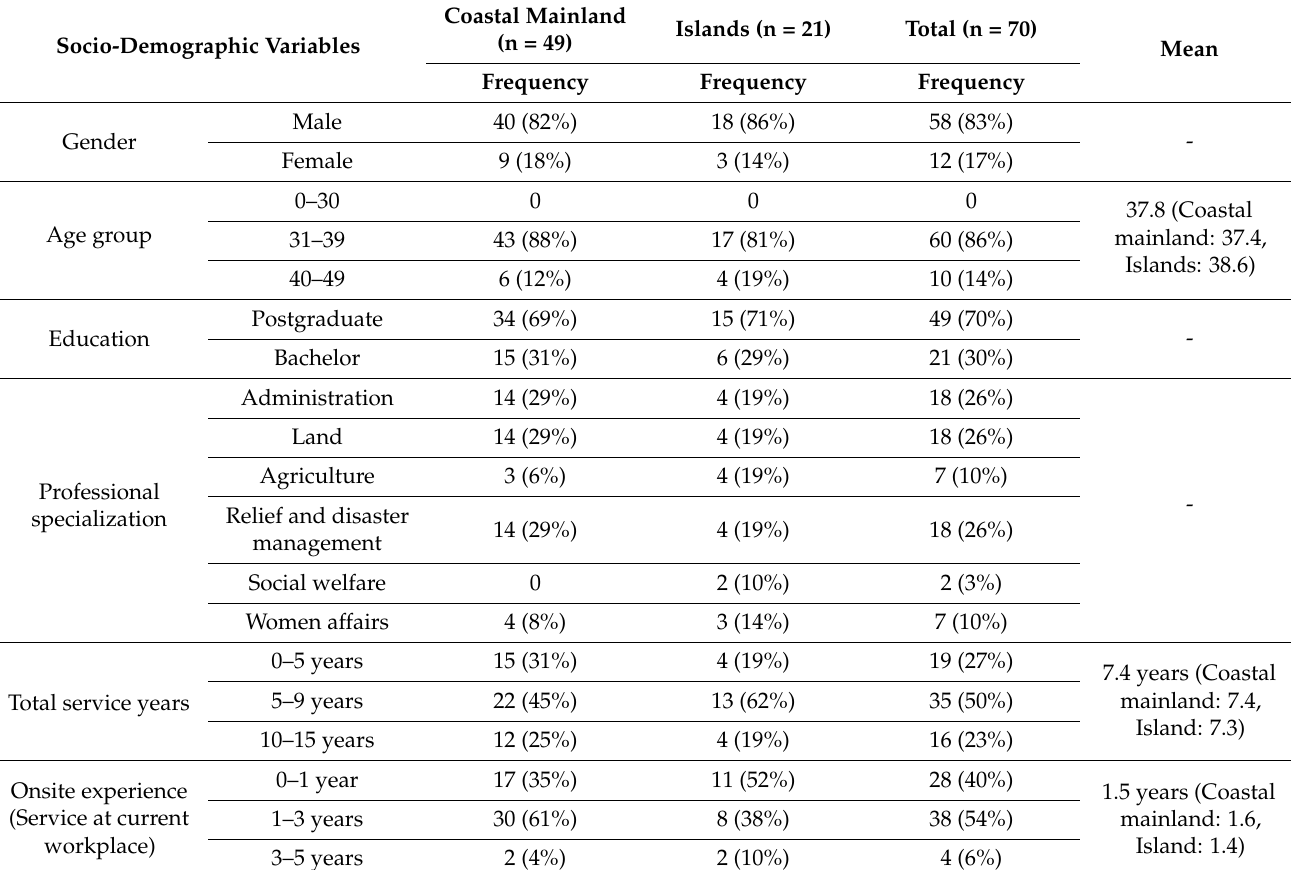
Table 1. Socio-demographic characteristics of the